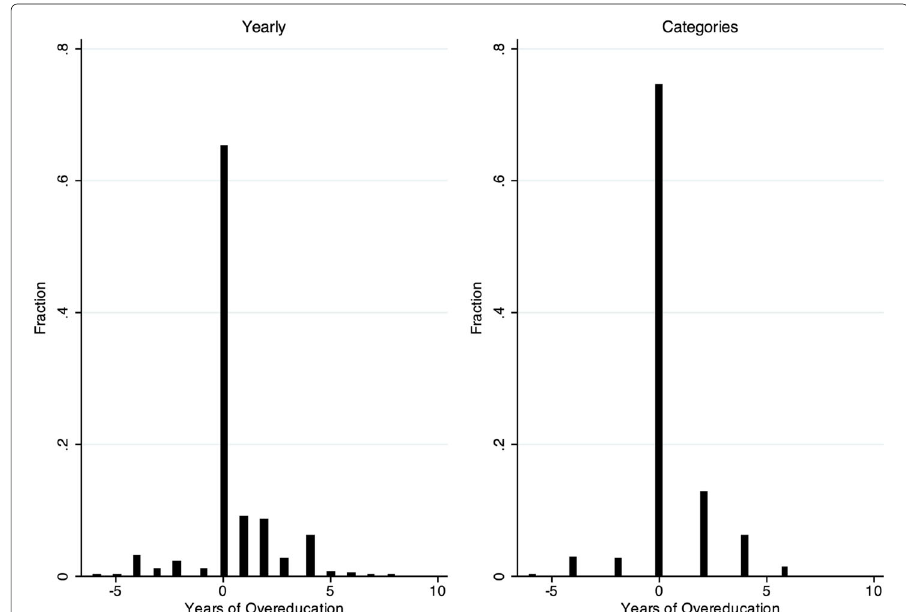
Fig. 1 Distribution of